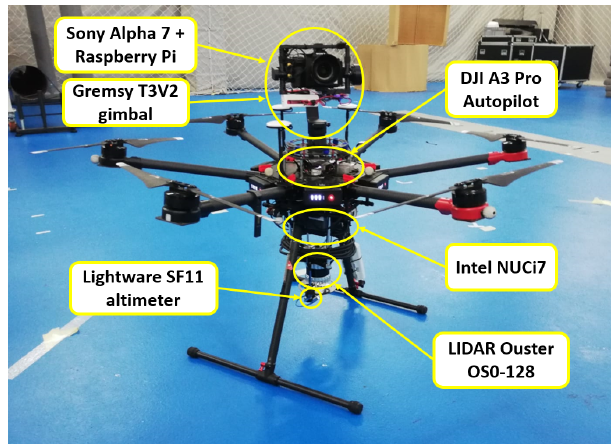
Figure 3. AERO-CAM robot for visual inspection